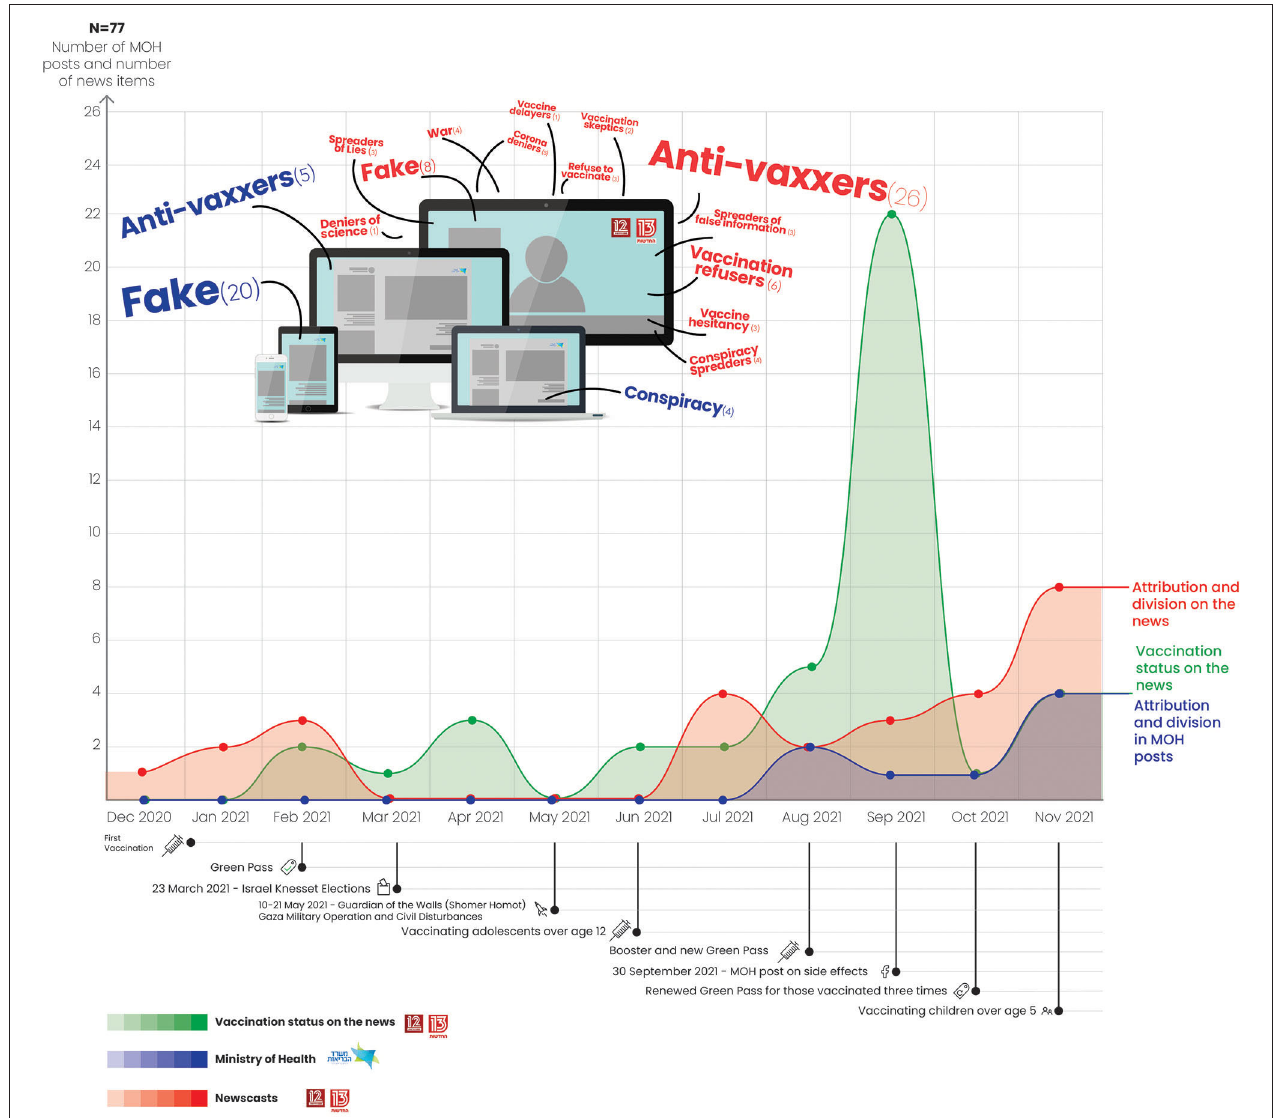
FIGURE 6 | Use of attribution of responsibility strategy: Newscasts vs. Ministry of Health Plus Word Cloud depicting vaccination